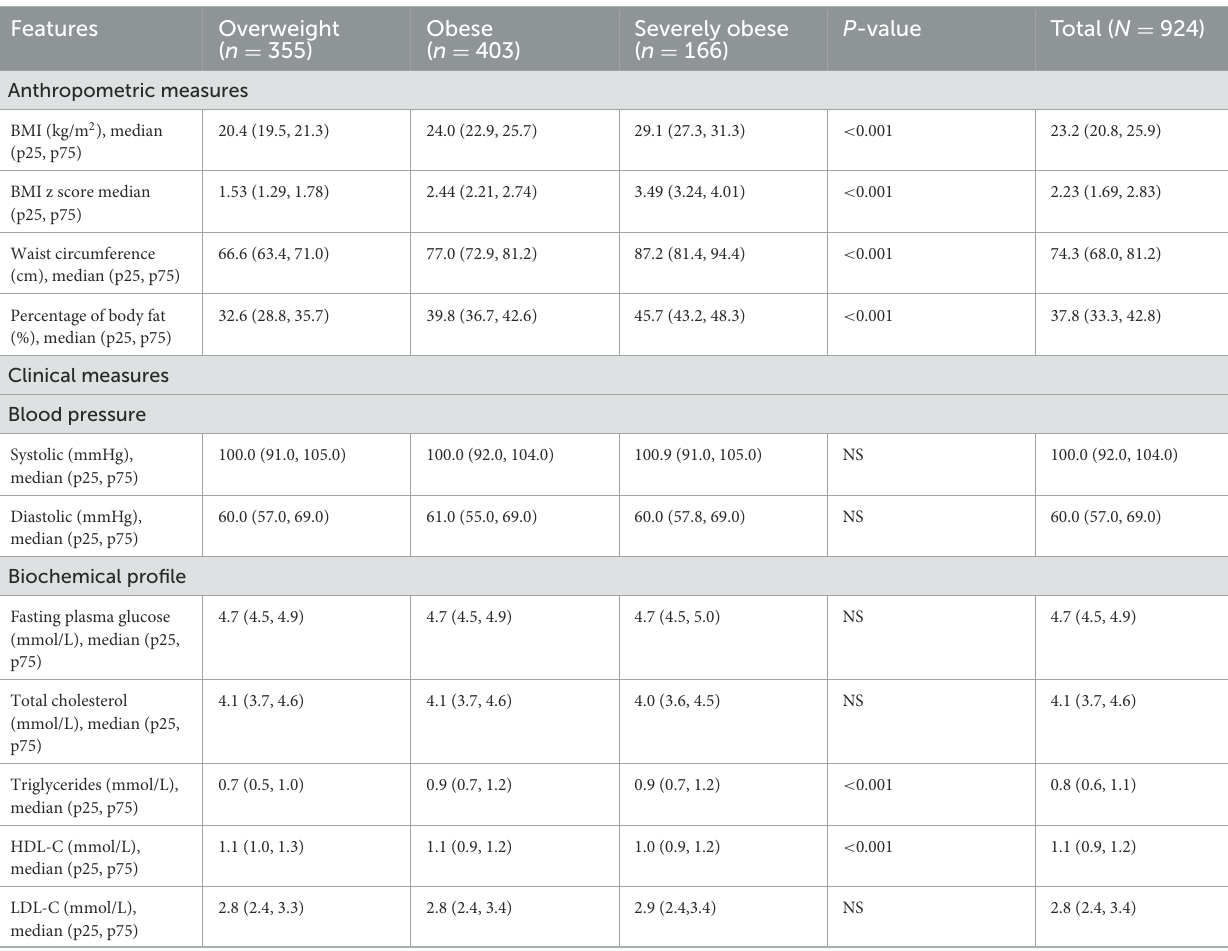
TABLE 2 Anthropometric measures, clinical measures, and biochemical profile at baseline by obesity